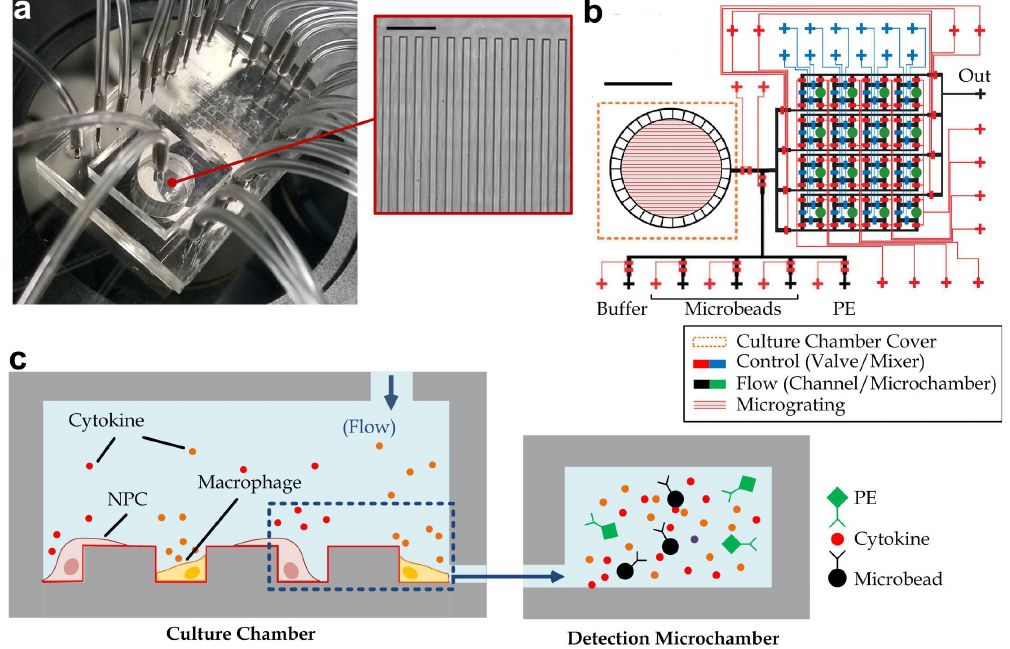
Figure 1. ( a ) Representative microscopic image of a microfluidic immunoassay device integrated with an ECM protein-coated topologic environment. Inset: microscopic image of the parallel grating array in cell culture chamber (grating width: 18 µ m, the depth: 18 µ m). Scale bar: 100 µ m. ( b ) The integrated microfluidic immunoassay device microchannels in the control layer consist of two functional units: valves ( cyan ) for micromixers and valves ( red ) for flow control. The flow channels are composed of an array of microchambers ( green ) for microbead trapping, connecting channels ( black ) between the cell culture region and the downstream cytokine detection arrays. Specially, the connecting microchannels surrounding cell culture chamber contained multiple micro-gaps (height 4 µ m; width 50 µ m) to allow liquid flow while simultaneously confining the cells in the culture chamber. Scale bar: 4 mm. ( c ) Schematic of the integrated microfluidic immunoassay device operation. Immune cells (macrophages) and nasopharyngeal cells (NPC) were co-cultured in the grating array-embedded cell culture chamber, and the media with secreted cytokines from the cell culture chamber were extracted and incubated with pre-loaded antibody-conjugated microbeads for capturing cytokines in one of the cytokine detection-microchamber. Fluorescent-conjugated detection antibodies were used to label the captured cytokine for microscopic imaging-based multiple cytokine